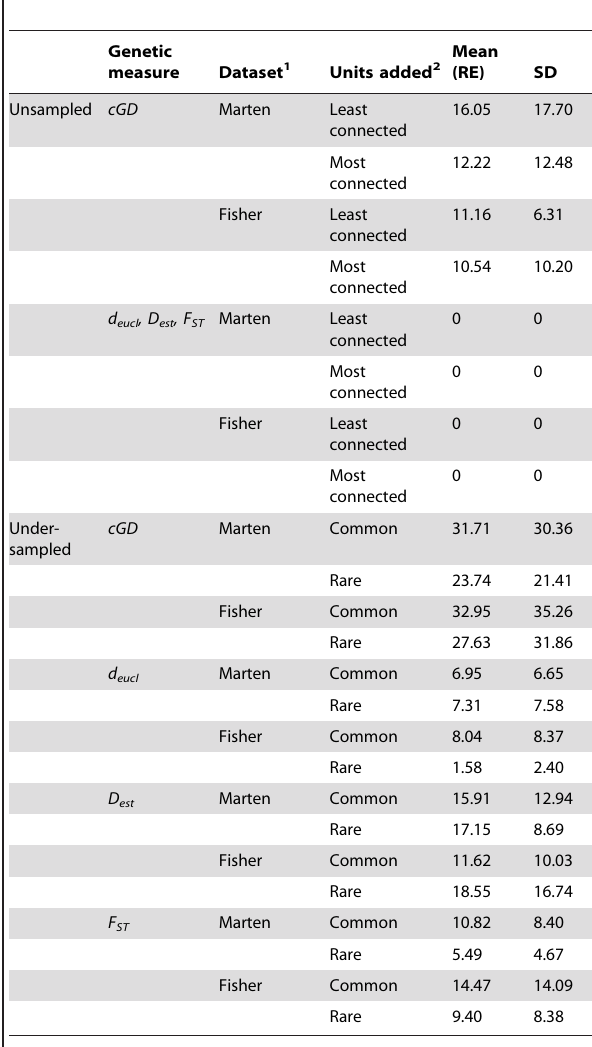
Table 2. Absolute mean percent relative error (RE) of genetic distance estimates across iterations.